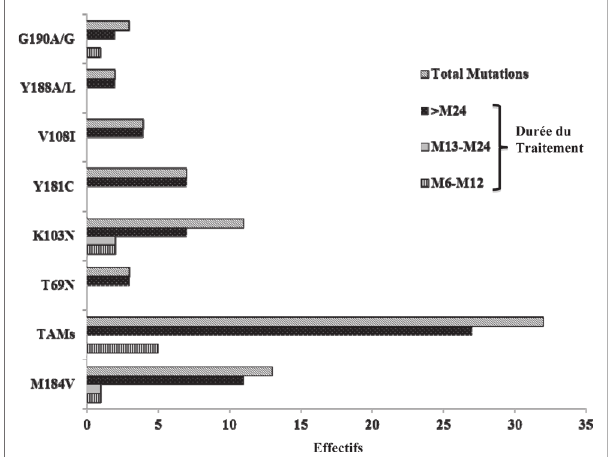
FIGURE 2: Fréquences des mutations observées en fonction de la durée du